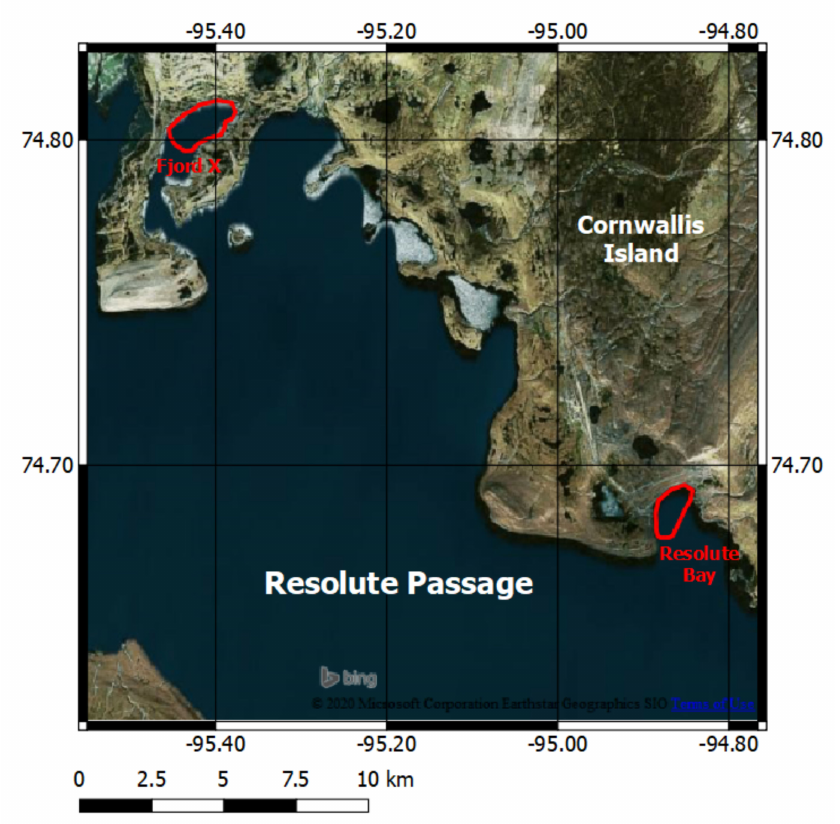
Figure 1. Map of the experimental site showing the location of Resolute Bay and Fjord X. Red polygons indicate the selected samples.